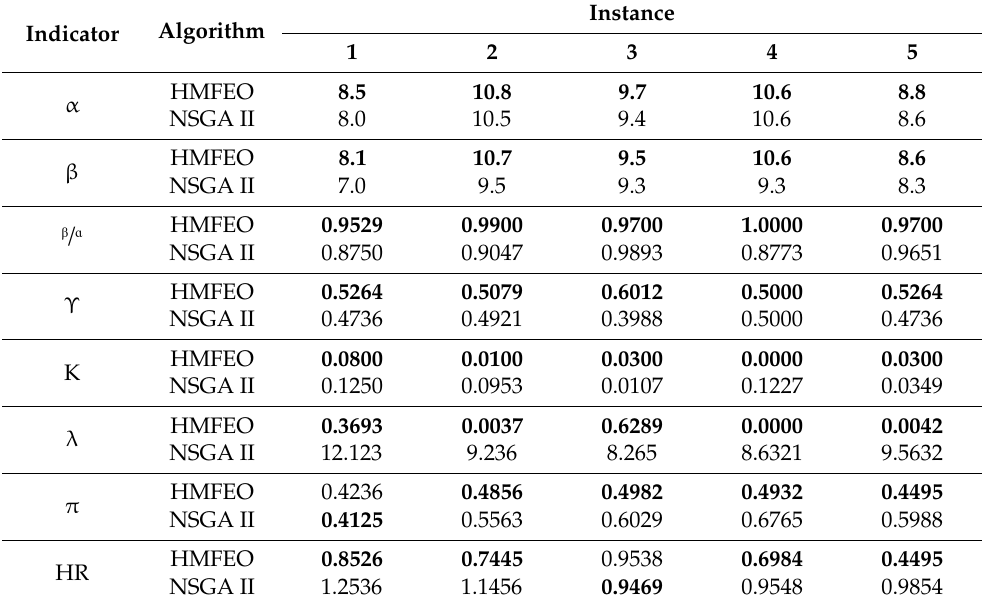
Table 10. Results of performance indicators for comparison of HMFEO and NSGA II instance 1–5.